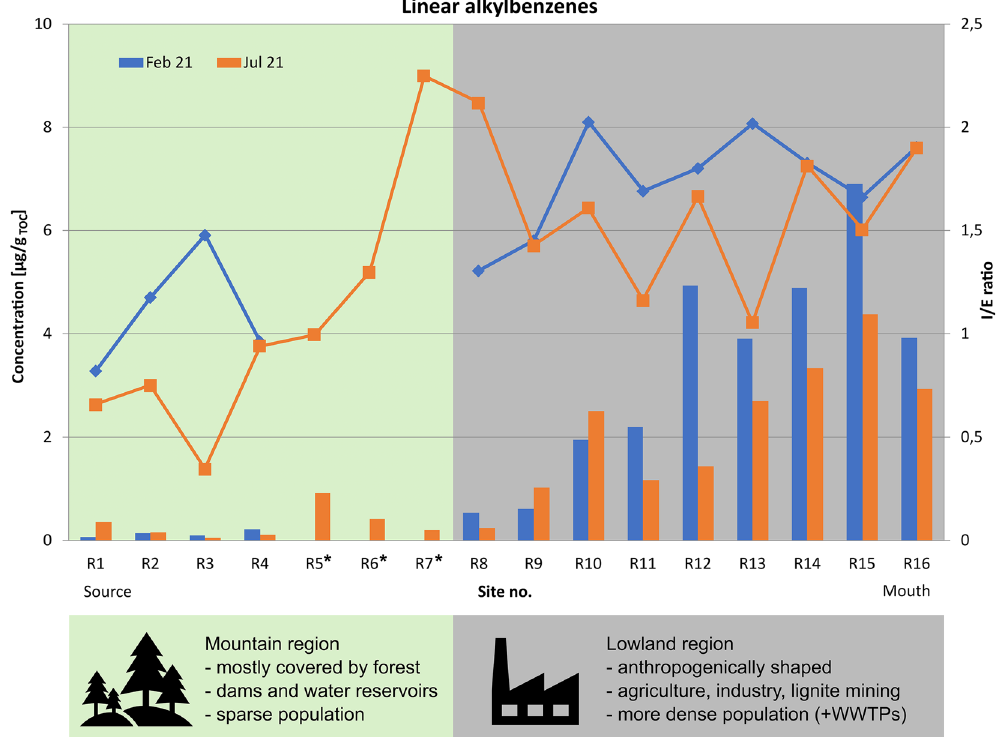
Fig. 3 Spatial distribution of LAB concentrations and I/E ratios [µg/g TOC ] over the Rur River course. I/E ratios close to 0.7 represent untreated wastewater, while higher values represent ongoing microbial degradation according to Takada and Eganhouse [48]. (*) R5 to R7 were not